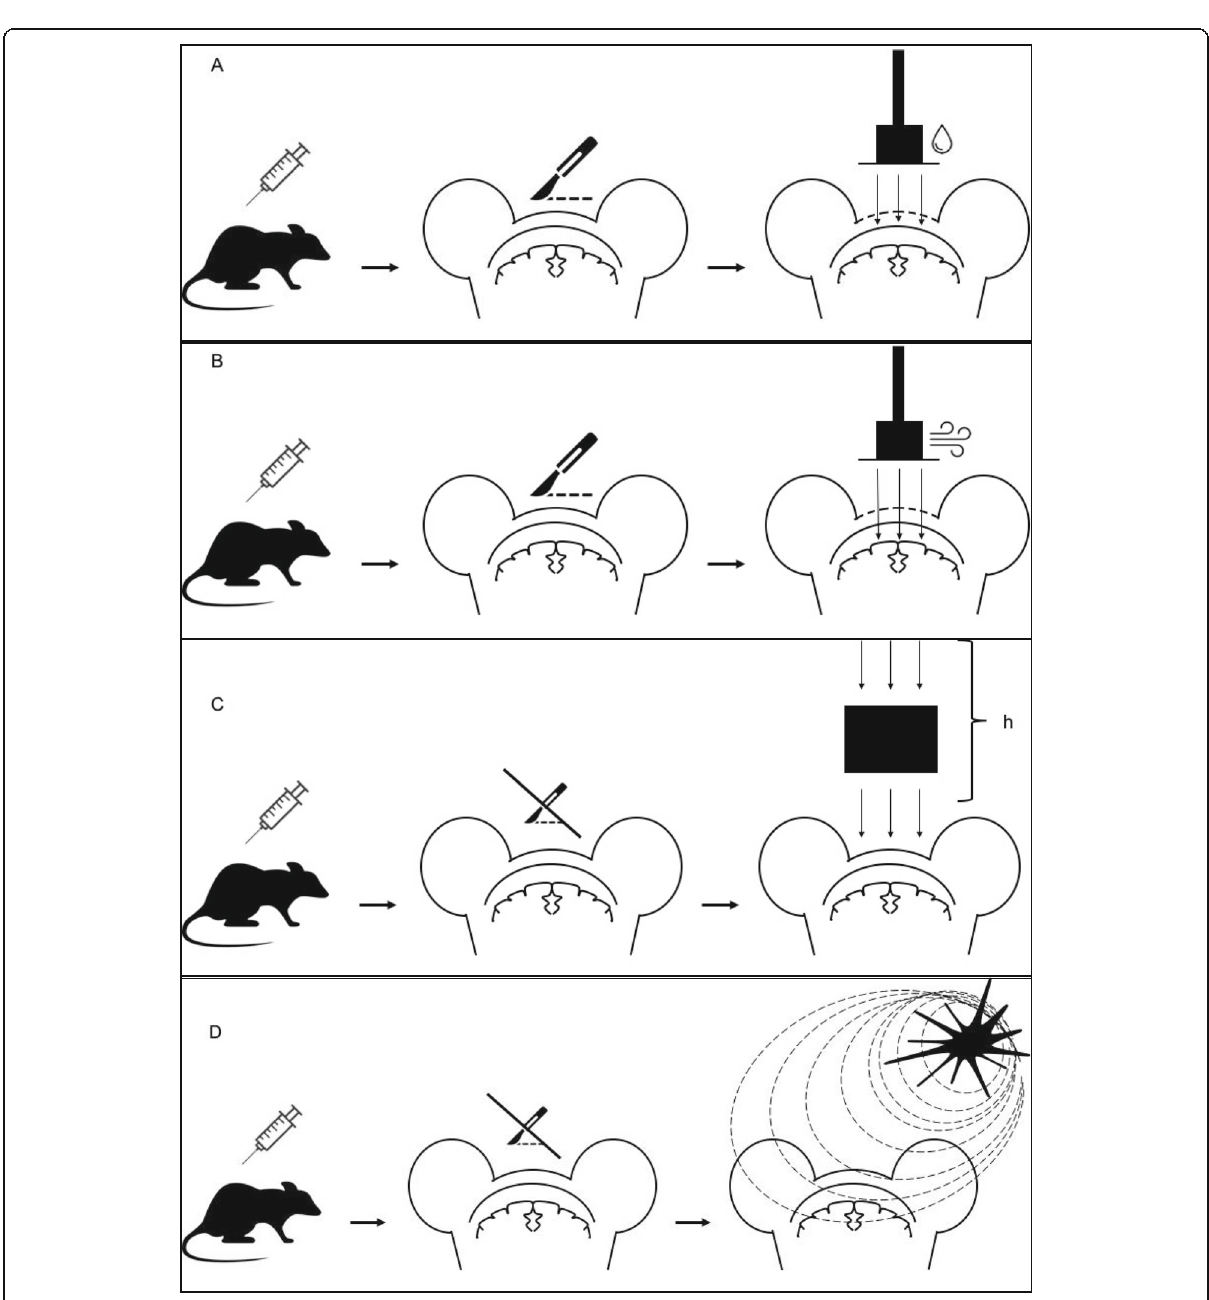
Fig. 1 Most common animal models of traumatic brain injury (TBI). Penetrative injuries (a,b). The lateral fluid percussion, LFP injury ( a ) is generated by a pulse of pressurized fluid to the intact dura mater through a craniotomy. The controlled cortical impact, CCI injury ( b ) is done by means of a pneumatic impactor that hits the cortex through a craniotomy. In penetrative injuries the dura may be damaged, especially in controlled cortical impact models. Non-penetrative injuries (c,d). In the weight-drop injury model ( c ) a weight falls from a predetermined height ( h ), hitting the head. In the blast injury model ( d ), the animal is exposed to an explosive detonation. Non-penetrative models are the most used to study post-traumatic headache. In TBI models, animals are previously